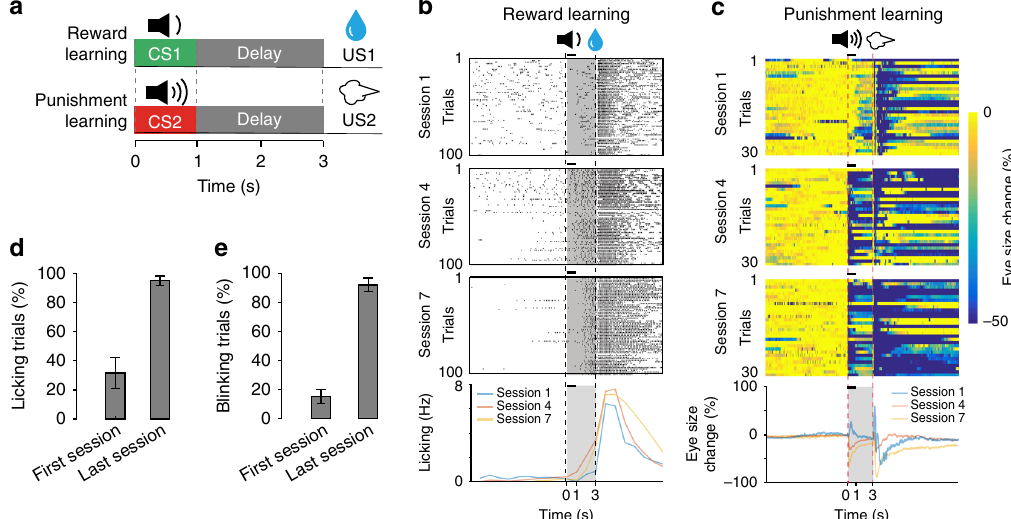
Fig. 2 The behavioral task. a A schematic of the behavioral procedure, in which mice were trained to associate CS1 (a 2 kHz tone) with US1 (water reward), and CS2 (a 10 kHz tone) with US2 (air-puff blowing to the face). b Changes in licking behavior during the reward learning for a representative mouse. The upper three panels are raster plots of licking events during early (session 1), mid (session 4), and late (session 7) training stages. The bottom panel shows average licking rate over time (1-s bin) for each of the three sessions in the upper panels. Licks are aligned to the onset of CS1 ( t = 0; the duration of CS1 (1 s) is indicated by a black bar above each panel). The delivery of US1 (water) was at 3 s after CS1 onset. Licks in the shaded area represent predictive licking events. c Eye blinking, measured as eye size change over time (see Methods), during the punishment learning for the same mouse as that in ( b ). The upper three panels are heat-maps of eye blinking during early (session 1), mid (session 4), and late (session 7) training stages. The bottom panel shows average blinking over time for each of the three sessions in the upper panels. Eye blinks are aligned to CS2 onset ( t = 0; the duration of CS2 (1 s) is indicated by a black bar above each panel). The delivery of US2 (air-puffs) was at 3 s after CS2 onset. Eye blinks in the shaded area represent predictive blinking events. d and e The percentage of trials in which mice showed predictive licking ( d ) or blinking ( e ) (i.e., trials with at least one lick ( d ) or blink ( e ) event in the shaded area) in the fi rst and last training sessions (the fi rst 10 trials of each session were used for analysis) ( n = 6